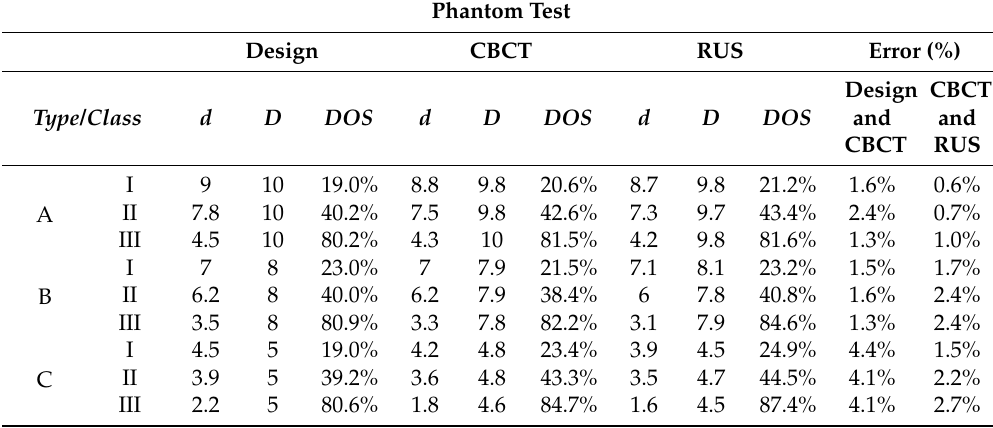
Table 1. Comparison table for phantom test. CBCT = cone beam computer tomography.